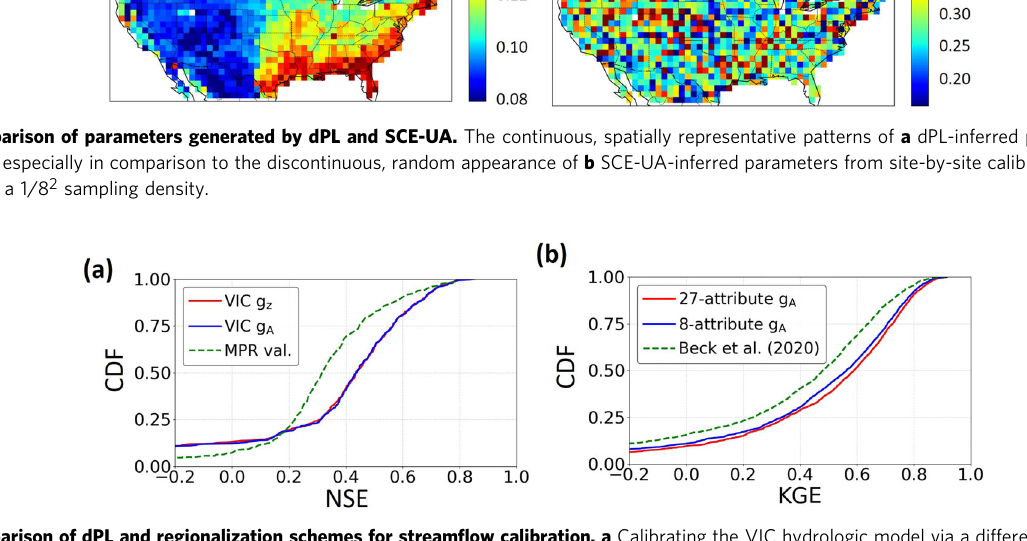
Fig. 6 Comparison of dPL and regionalization schemes for stream fl ow calibration. a Calibrating the VIC hydrologic model via a differentiable surrogate model on the CAMELS dataset over the conterminous United States, in comparison to Multiscale Parameter Regionalization (MPR). b Calibrating the HBV hydrologic model (not a surrogate) on the Beck20 global dataset, in comparison to the Beck20 regionalization scheme. We used NSE for the CAMELS case and KGE for the global case because these metrics were used by the respective papers, and the main purpose of the case studies was to compare with the existing literature. For both panels, curves on the right represent better